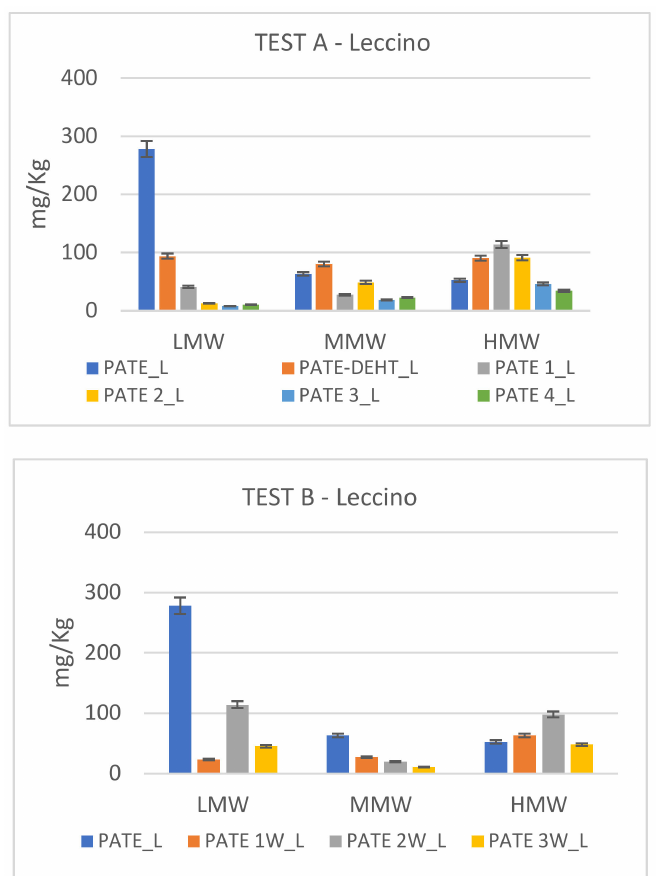
Figure 2. Secoiridoid profile modification in Leccino cv. during chemical debittering (Test A) and microbial fermentation (Test B). Data, expressed in mg / kg, are the mean of duplicate analyses and the coe ffi cient of variation is <